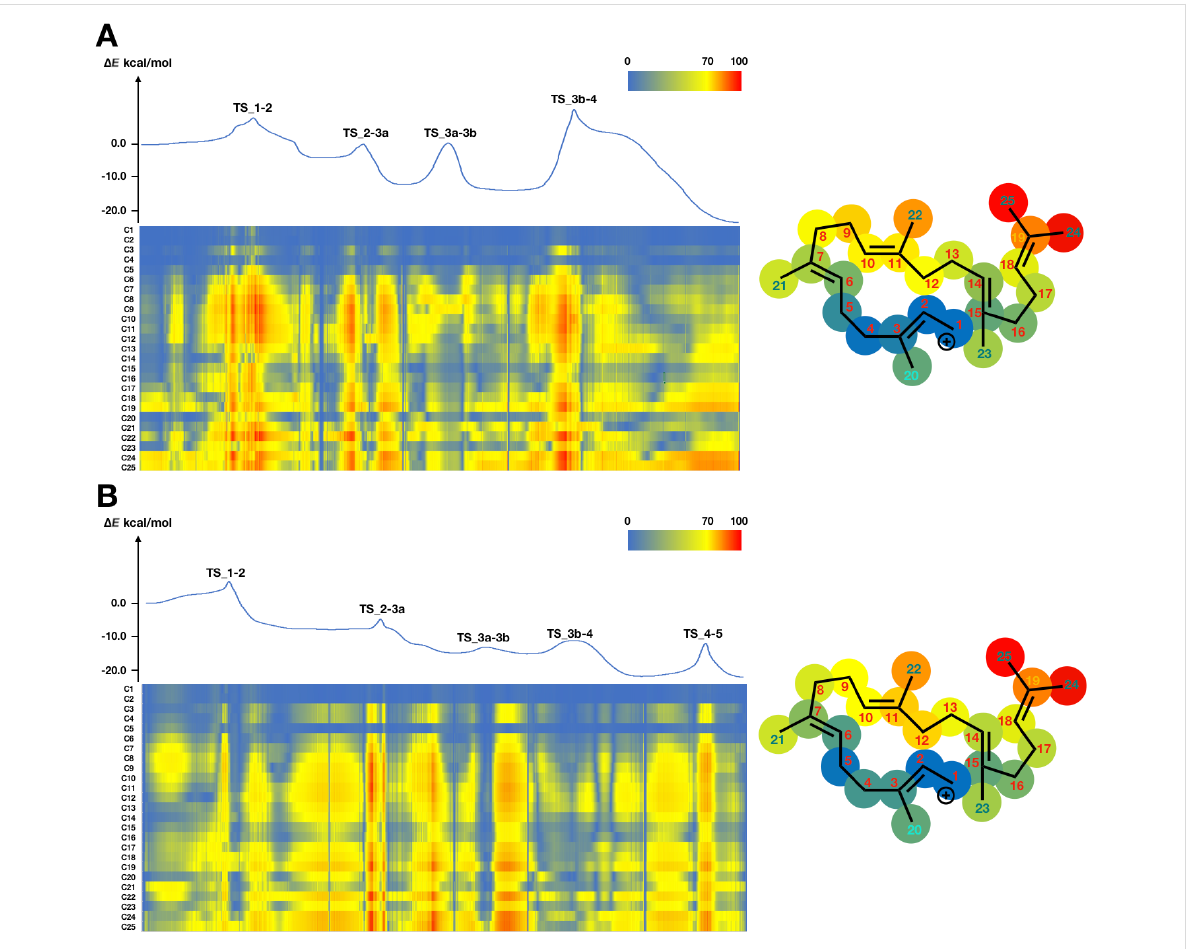
Figure 1: Energy diagram and heat map analysis of 5/12/5 tricycle formation (A) IM1–IM4 in quiannulatene biosynthesis. (B) IM1–IM5 in sester- fisherol biosynthesis. An energy diagram, heat map of inherent mobility and structural heat map are shown. All energies are shown in kcal/mol. The Y axis shows the carbon number and the X axis shows the coordinate in the heat map. The right structural heat map shows the total mobility in tricycle formation. Red means high mobility, yellow means moderate mobility, and blue means static. TS: transition